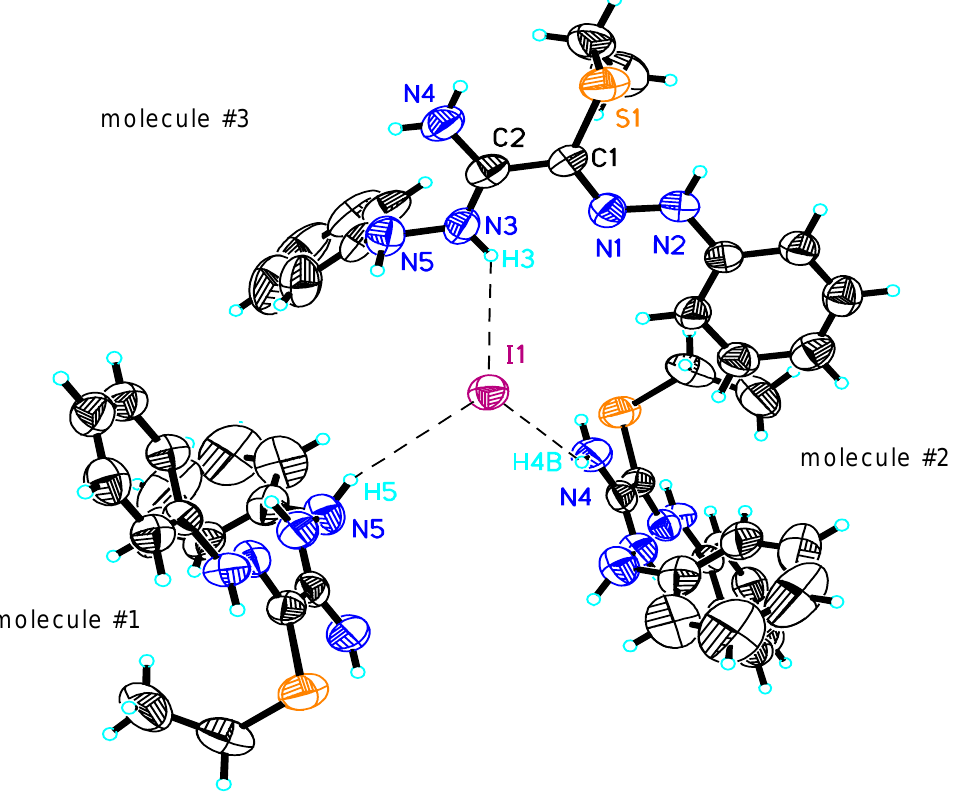
Figure 1. Arrangement of molecules of 4b in the crystal